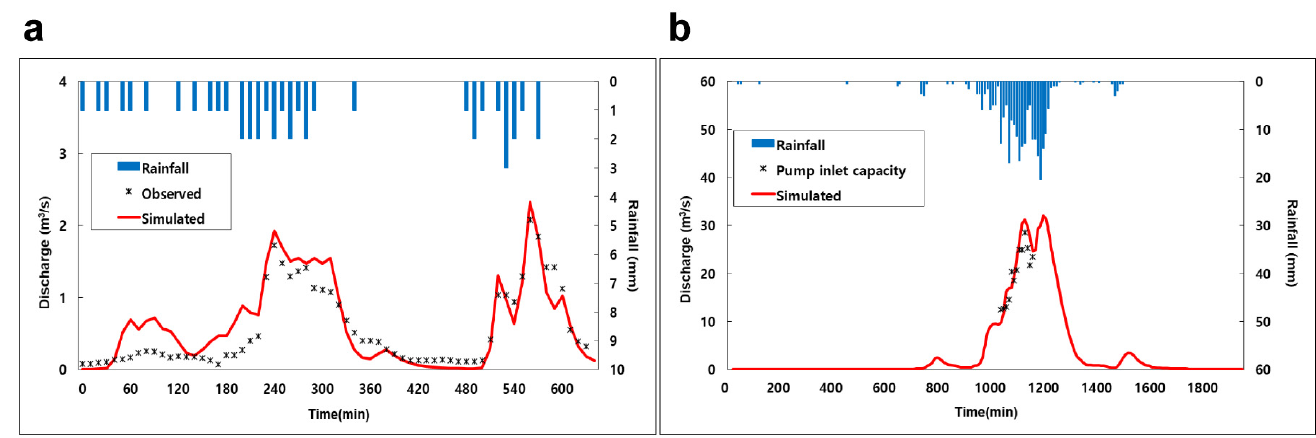
Figure 8. Calibration of the simulated results against measured runoff for the ( a ) Gunja and ( b ) Dorim watersheds.